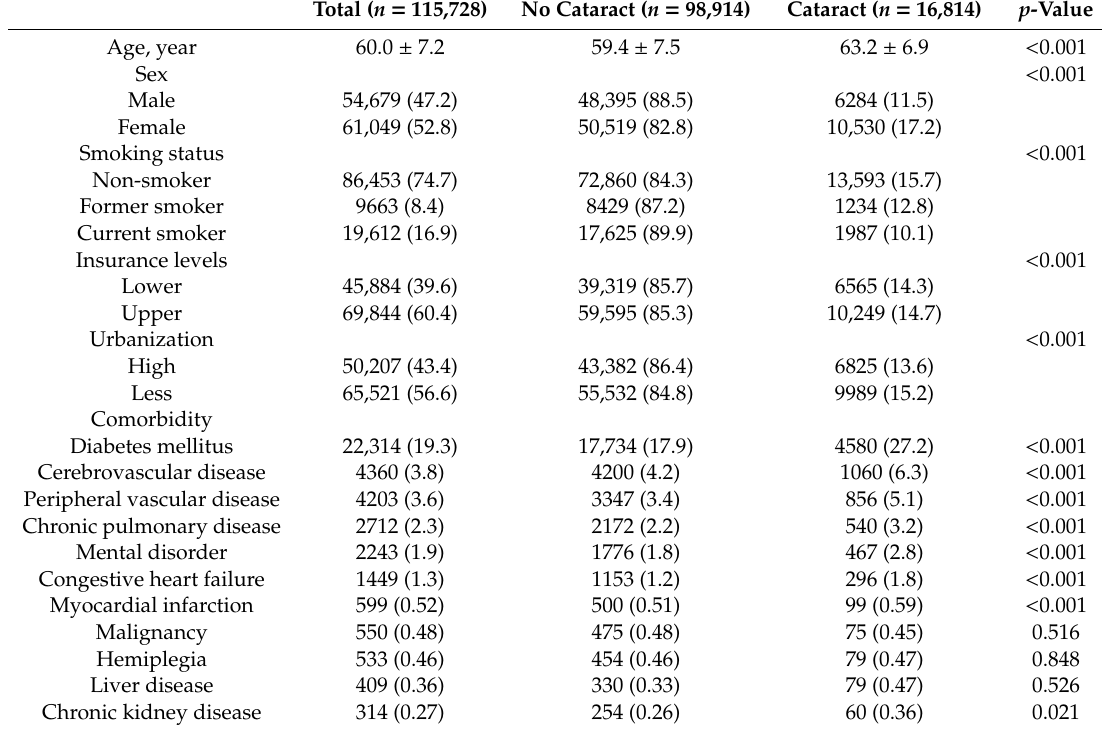
Table 1. Baseline characteristics of study